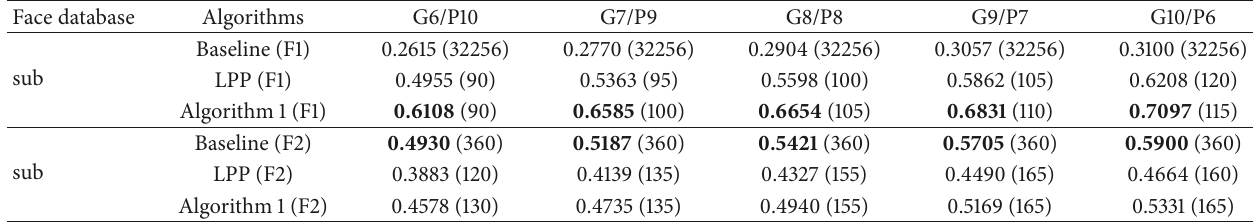
Table 16: The recognition rates on sub Extended Yale B face database over “F1” and “F2” features; recognition rates (dimensionality). Face database